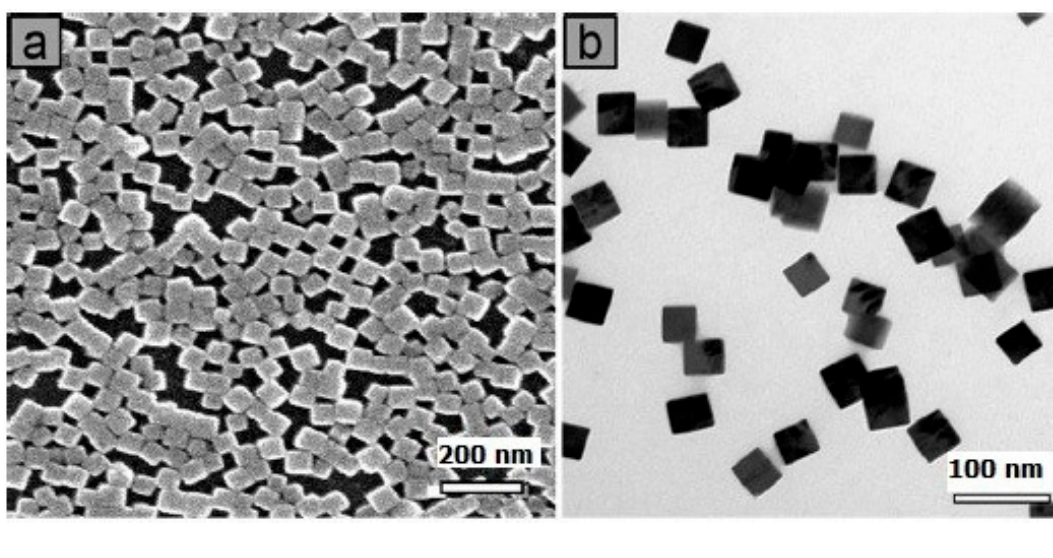
Figure 4. ( a ) SEM image of cubic formed CuO; ( b ) TEM image of CuO nano cubic.